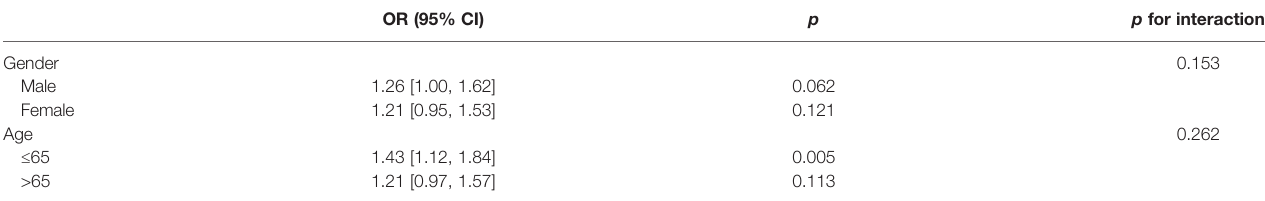
TABLE 4 | Subgroup analysis between C-peptide and SC-MI.